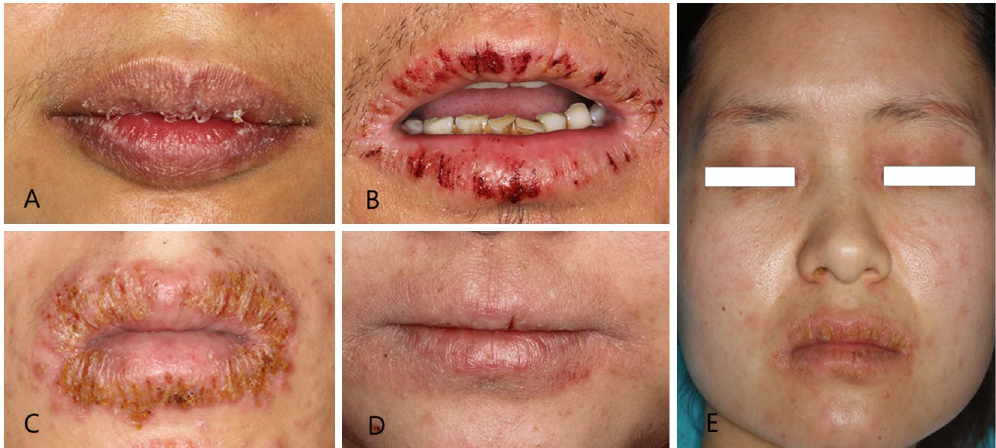
Figure 1. Phenotypes of chronic cheilitis. ( A ) Desquamation, ( B ) chapping, ( C ) effusion/eschar, ( D ) lack of color in the lip, ( E ) severe chronic cheilitis in a female patient with extensive lesions on the paraorbital, perioral and cheek